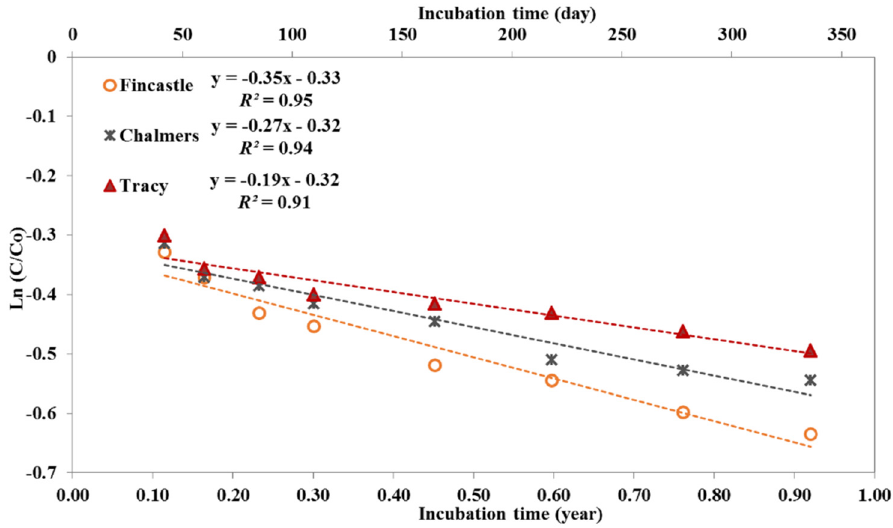
Figure 4. Variation in degradation rate (year − 1 , slope of trend line) for three soils based on first order kinetics (ln p C { C 9 q “ ´ kt ) and Terry et.al [8] laboratory decomposition data (incubated for 28 to 336 days at a temperature of 21 °C and moisture content of 20%).